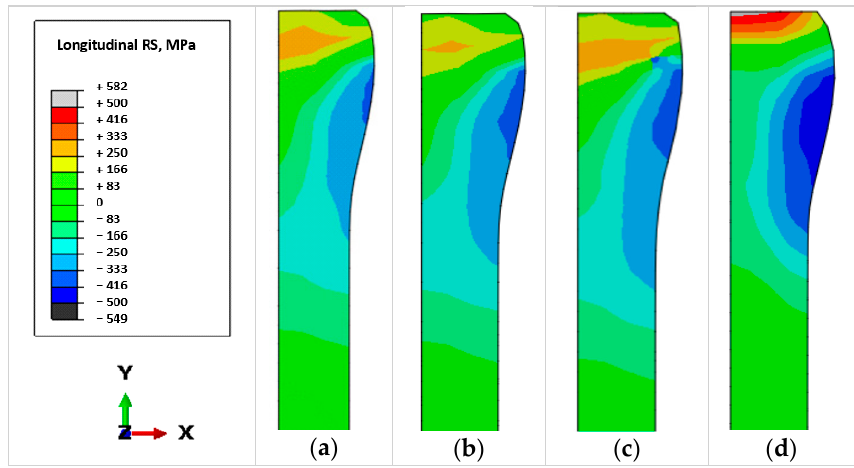
Figure 8. Longitudinal residual stress (RS) distribution on the inspection plane: ( a ) large scale implicit transient model (control model); ( b ) short implicit transient model; ( c ) short explicit transient model; ( d ) Eulerian steady-state model.